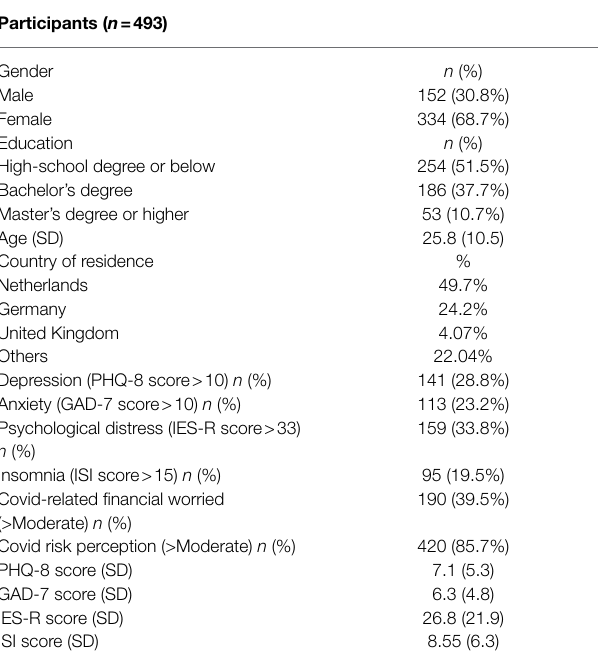
TABLE 1 | Sample characteristics and rates of participants exceeding cut-off for moderate depression, anxiety and insomnia and for COVID-19-related psychological distress, financial worries and risk